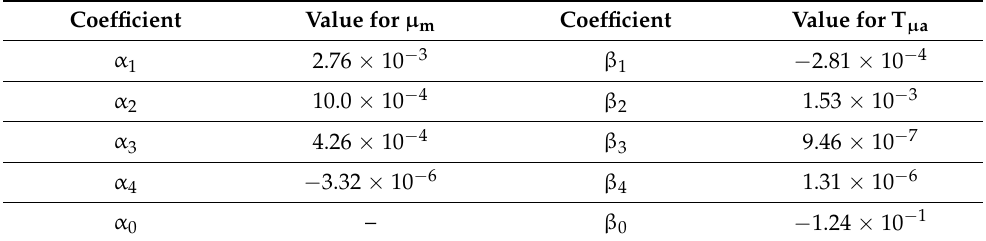
Table 7. Multiple regression coefficients of the simplified model of the average coefficient of friction and the tolerance of the instantaneous coefficient of friction.